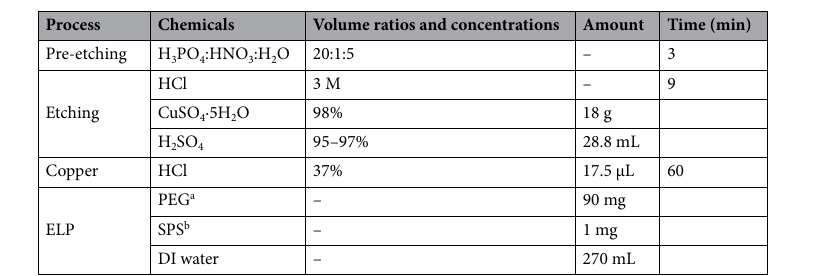
Table 1. The conditions of pre-etching, HCl etching, and the copper electroless plating bath. a Polyethylene glycol. b Bis-(sodium